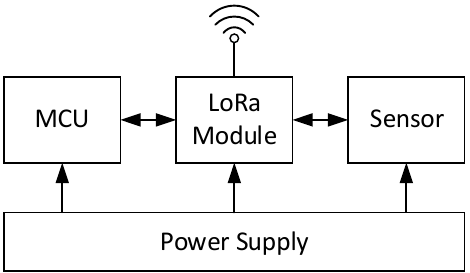
Figure 5. Internal structure of the sensor.